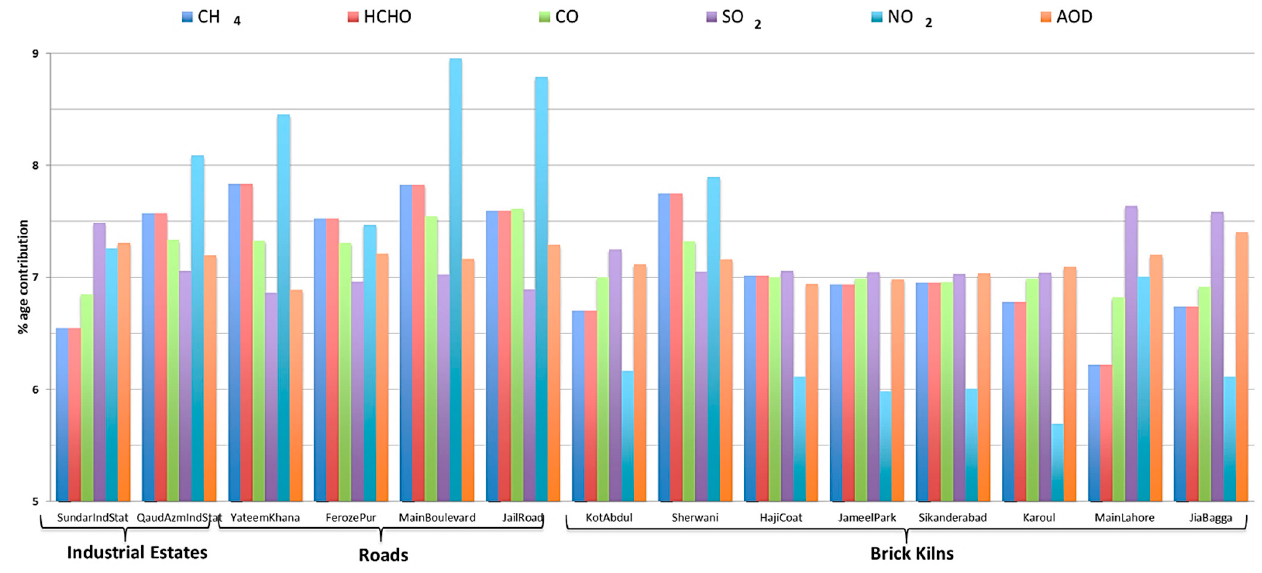
Figure 4. The percentage contribution of each site on the corresponding pollutant.